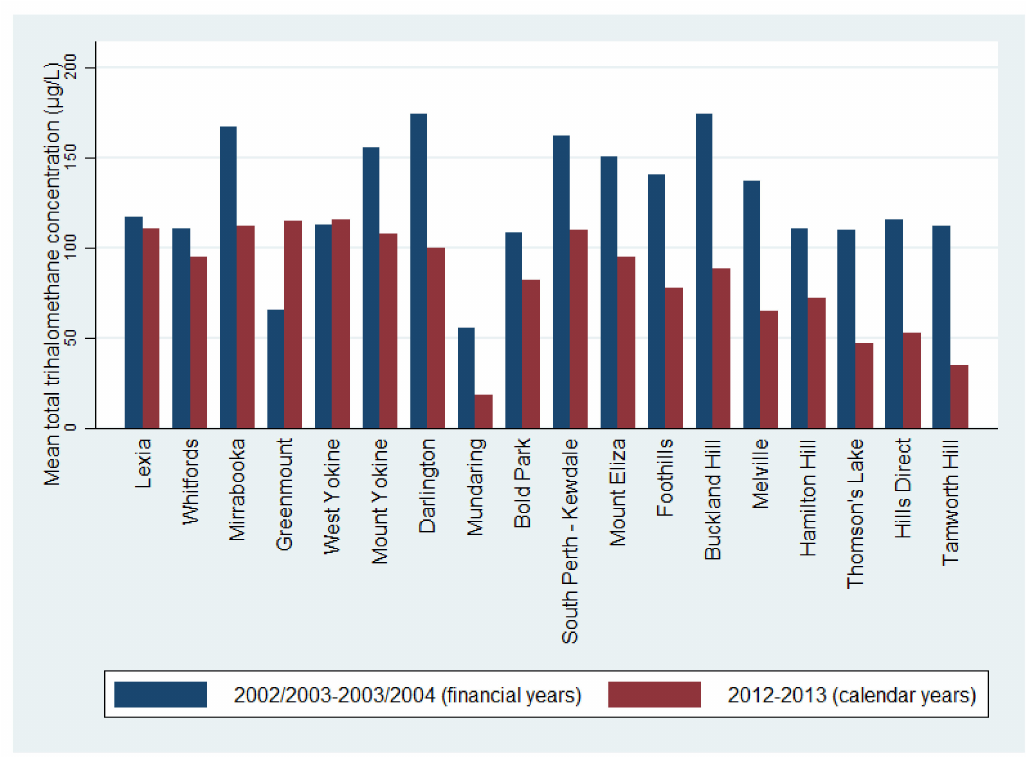
Figure 2. Mean total trihalomethane concentrations ( µ g / L) from 2002 / 2003 to 2003 / 2004 financial years (July–June) [19] and 2012–2013 calendar years (January–December) by water distribution zone. Only water distribution zones with data available at both time points are reported.